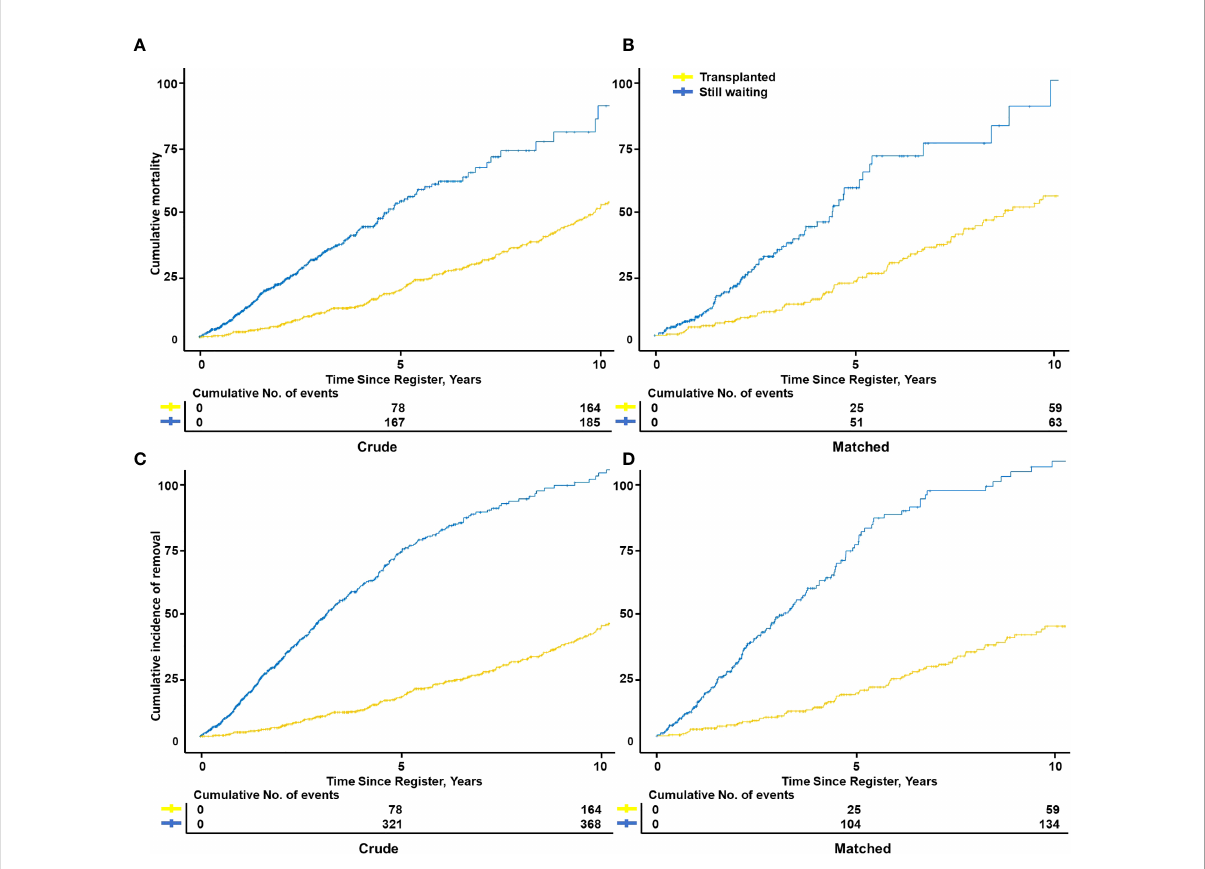
FIGURE 4 Cumulative mortality or removal incidence of transplanted vs. still waiting among RCC-induced ESRD patients. Kaplan – Meier curves showed patient cumulative mortality between transplanted and still-waiting patients from register to death, both before (A) and after (n=323) matching (B) . Considered some still-waiting patients were removed due to death or deterioration, the patient cumulative removal incidence from the registration to removal of two groups was compared both before (C) and after (D) matching. Matching variables: Age, body mass index, sex, ethnic, diabetes history, primary insurance, education